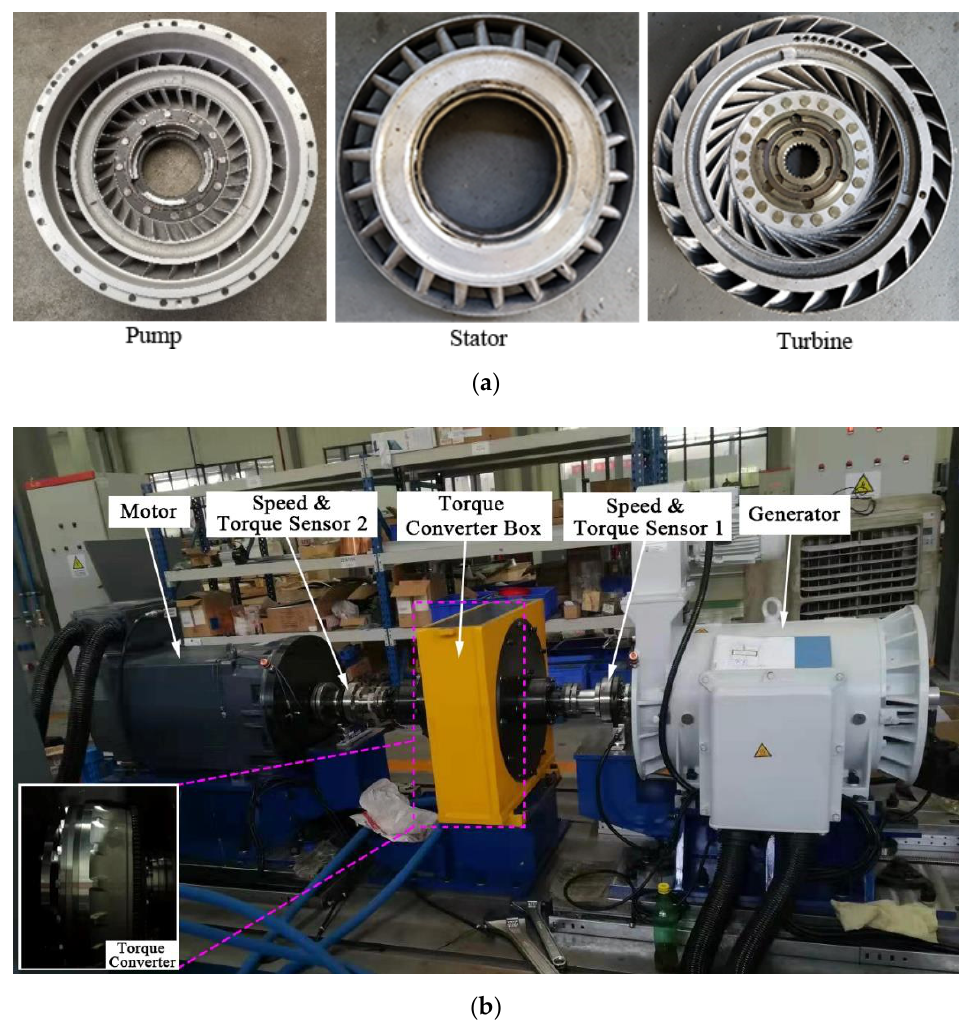
Figure 7. The prototype and test rig of the torque converter: ( a ) experimental prototype; ( b ) test rig. The external characteristics of the torque converter are composed of the torque ratio ( K ), the efficiency ( η ), the nominal torque ( T bg ), and the high-efficiency region width ( G η ) under different speed ratios. ( K = M T / M P ; i = ω T / ω P ; η = K × i ; T bg = M P / ( ω P /1000 ) 2 ; G η = i p 2 / i p 1 ( η p = 0.75 ) ). M T is the turbine torque (Nm), M P is the pump torque (Nm), ω